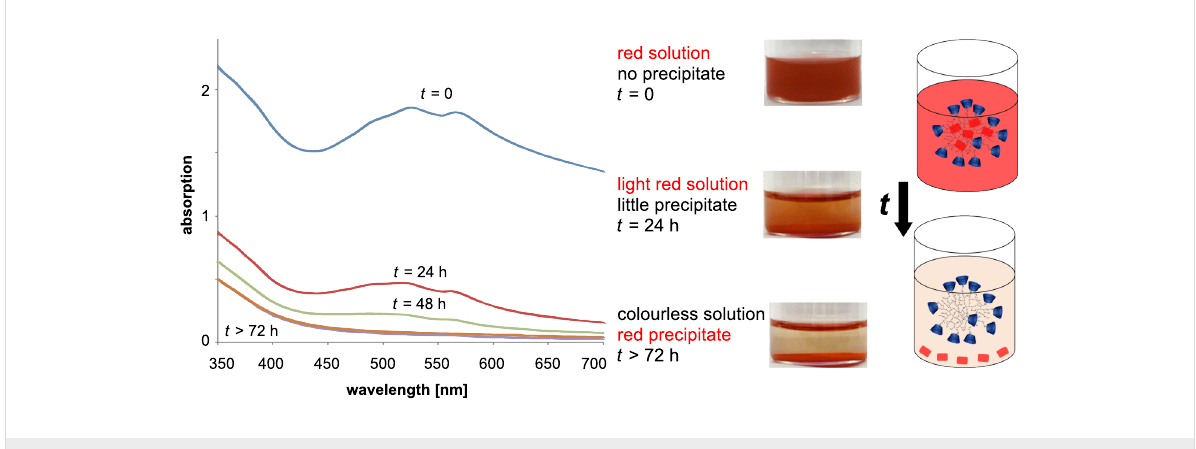
Figure 1: UV–vis spectra of complex 4 in basic solution (pH 10, t = 0 (blue line), t = 24 h (red line), t = 48 h (green line), t > 72 h (orange line and violet line)), and corresponding photos and schematic illustrations of the solution.